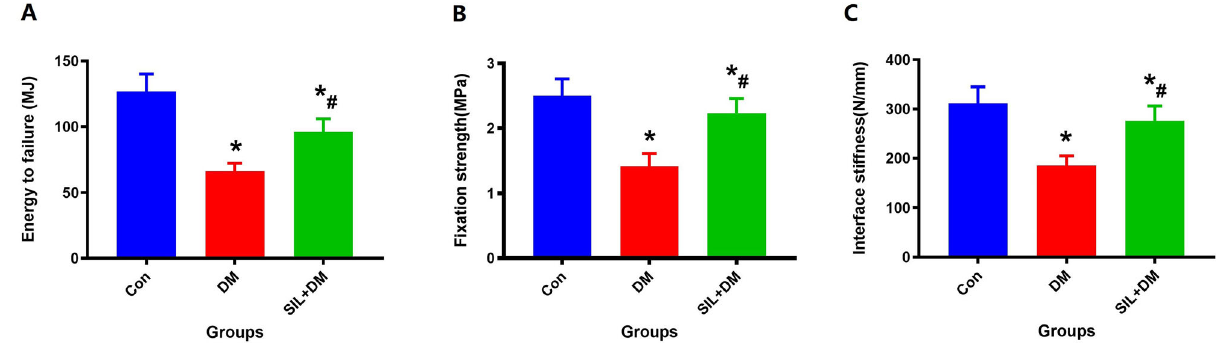
Fig. 7 Local therapy with SIL can greatly enhance the mechanical pull-out data including energy to failure ( A ), fi xation strength ( B ) and